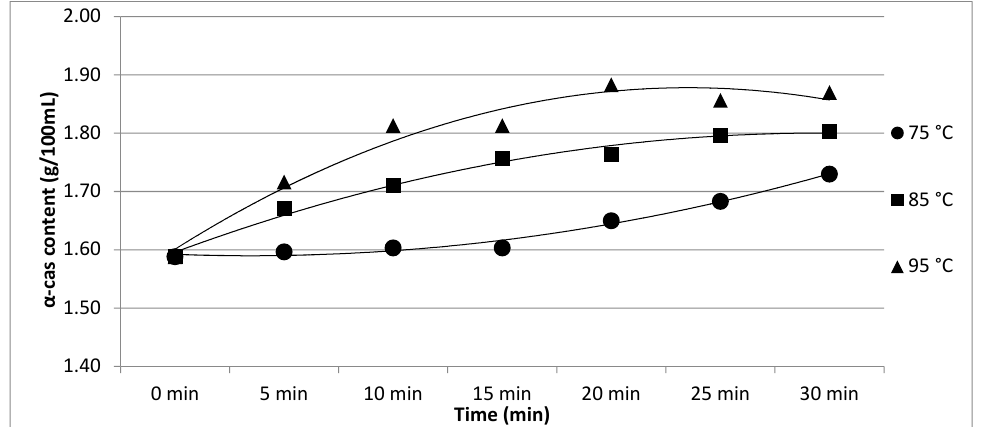
Figure 6. Effect of heating temperature and time on α -cas content. Equations: 75 °C (y = 0.005x 2 − 0.0168x + 1.604; R 2 = 0.9836), 85 °C (y = − 0.0058x 2 + 0.0809x + 1.5209; R 2 = 0.9868), 95 °C (y =